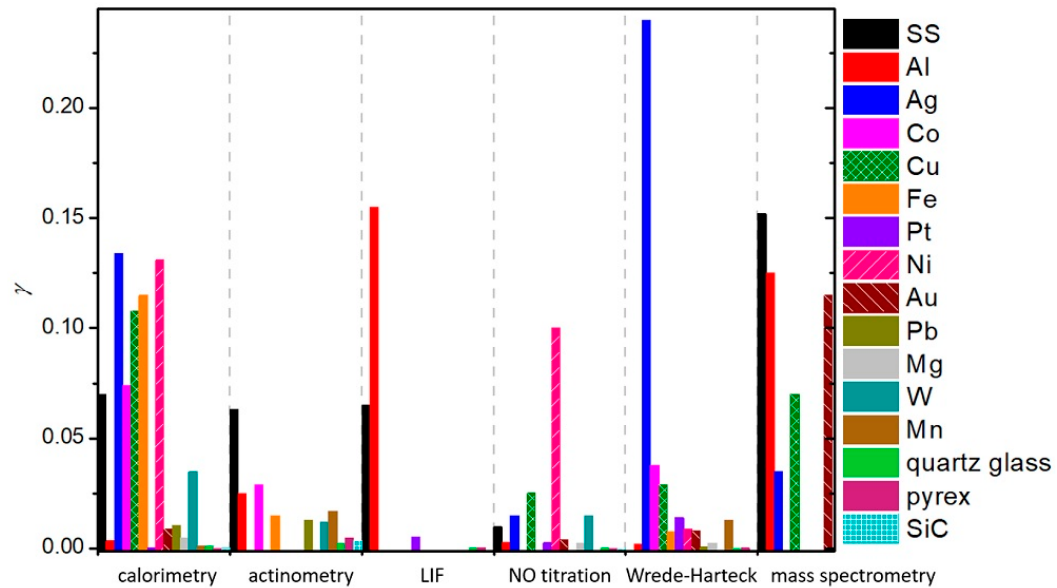
Figure 13. Comparison of average γ determined using different measuring techniques. Table 3. Advantages and disadvantages of various types of measuring methods for determination of the neutral atom density and recombination coefficient.